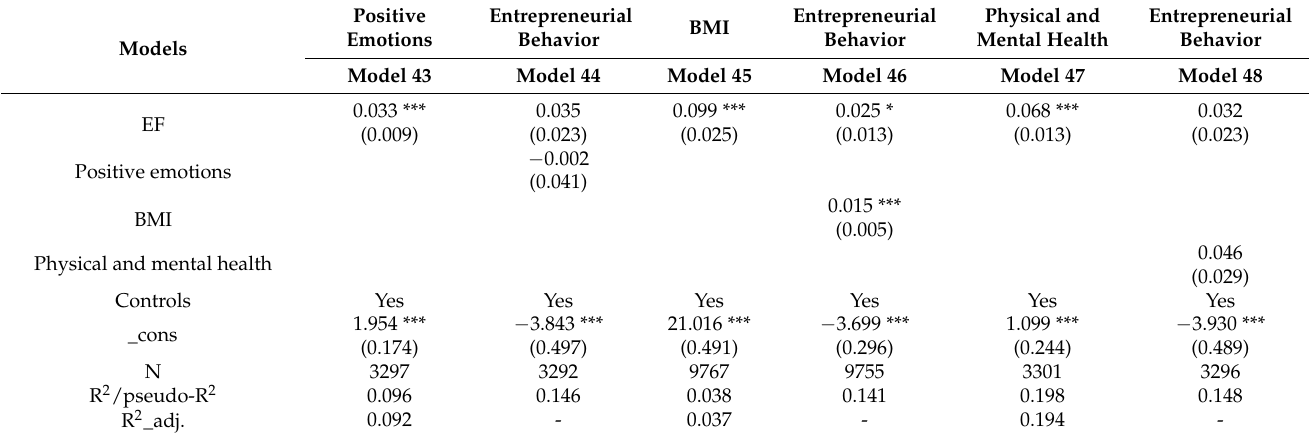
Table 9. Mediating effect test for the relationship between exercise frequency and entrepreneurial